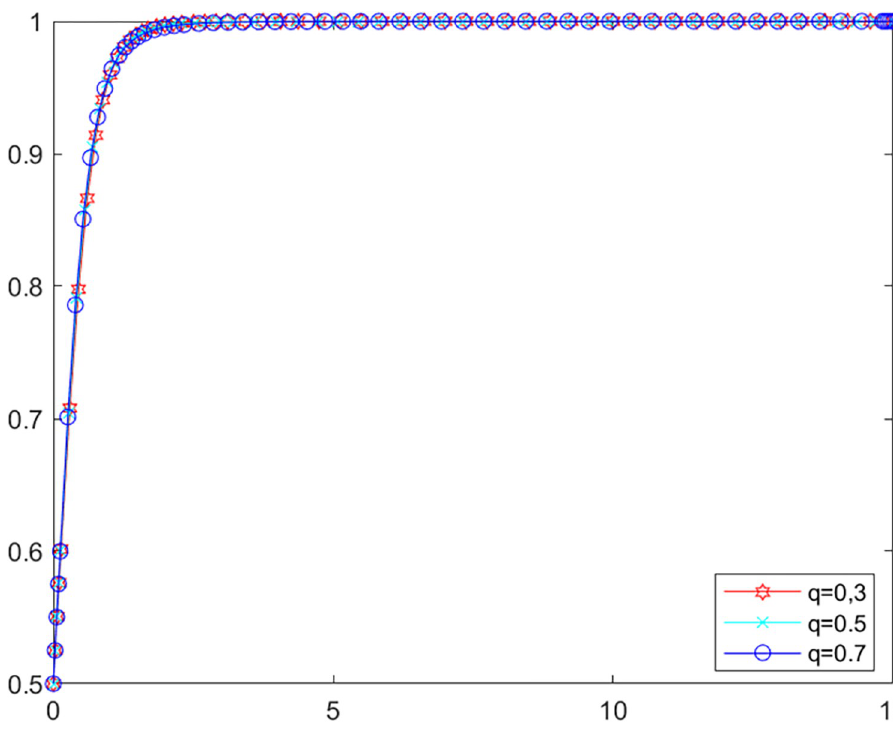
Fig 8. Government’s evolutionary path.